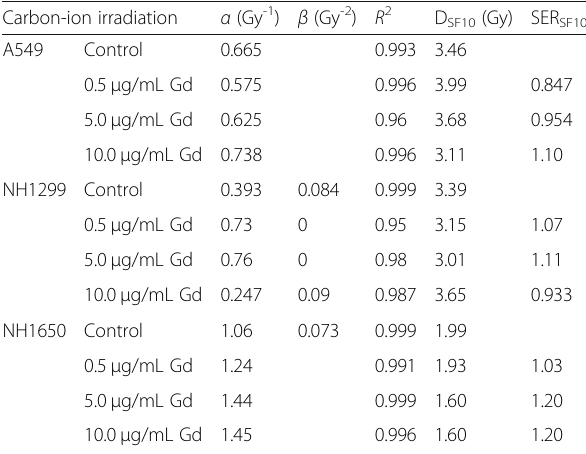
Table 1 Summary of fitting parameters, D SF10 , and SER SF10 in the absence or presence of GONs Carbon-ion irradiation